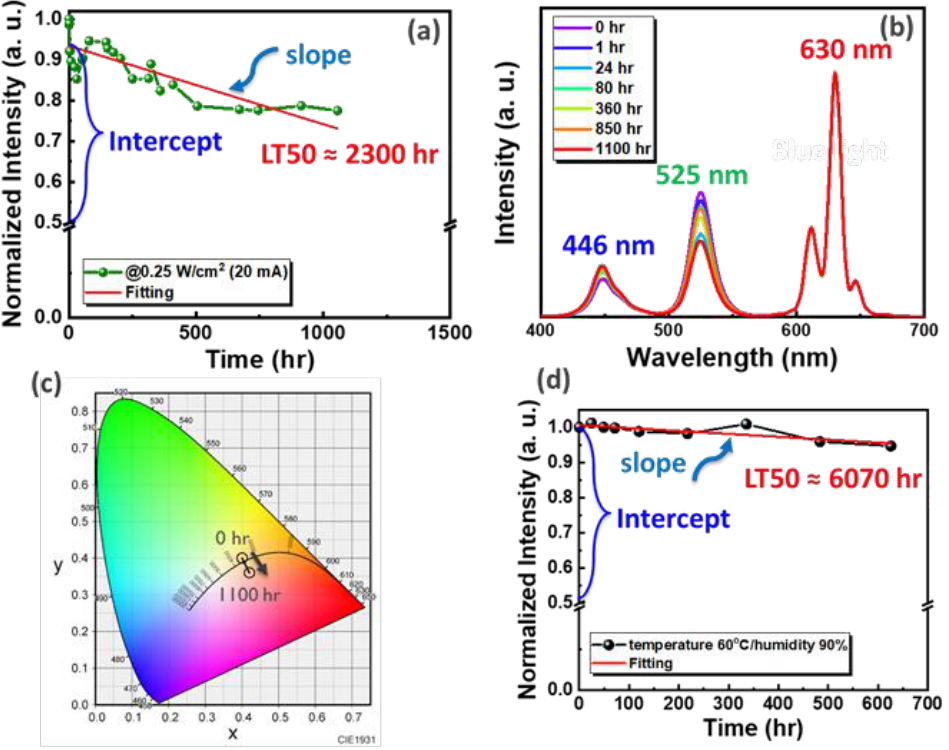
Figure 4. Reliability test of white PeQD composite film. White PeQD composite film (20 mA) excited with blue light: ( a ) decay trend image, ( b ) emission spectrum, and ( c ) CIE color coordinates. ( d ) Aging test at 60°/90%.